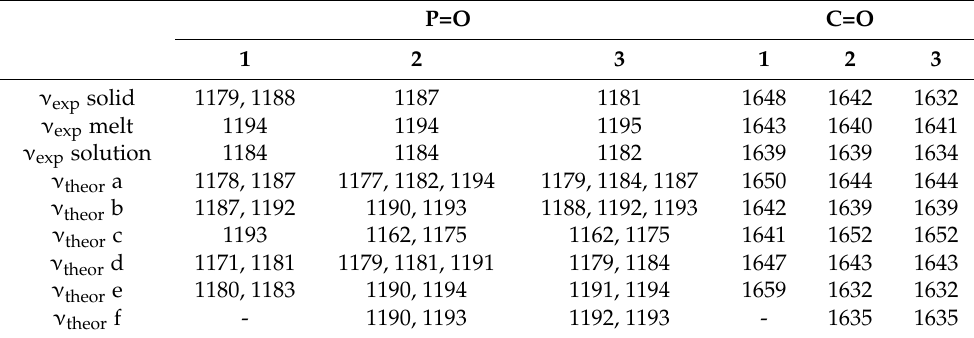
Table 5. Selected vibration frequencies of the phosphoryl and carbonyl groups of 1 – 3 ; theoretical values are listed for conformers a–f.